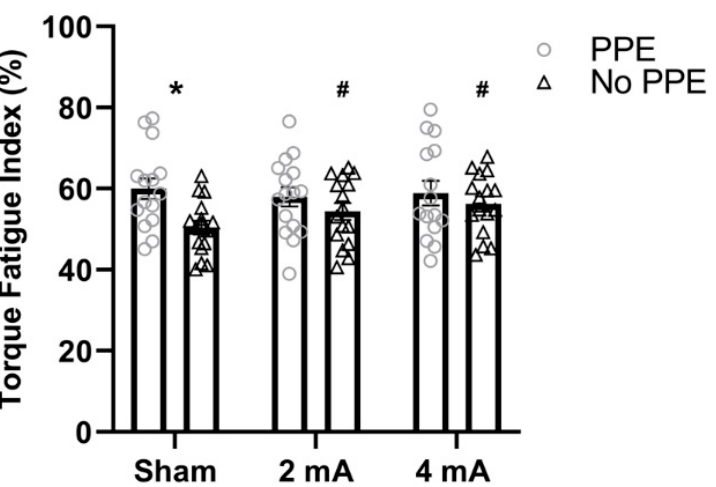
Figure 1. Fatigue index derived from the torque data for the right knee extensors stratified by tDCS condition (sham, 2 mA, and 4 mA) and study (PPE vs. No PPE). * Significantly larger (i.e., increased fatigability) than the No PPE study [6] in the same tDCS condition (sham). # Significantly larger (i.e., increased fatigability) than sham in the same study (No PPE).